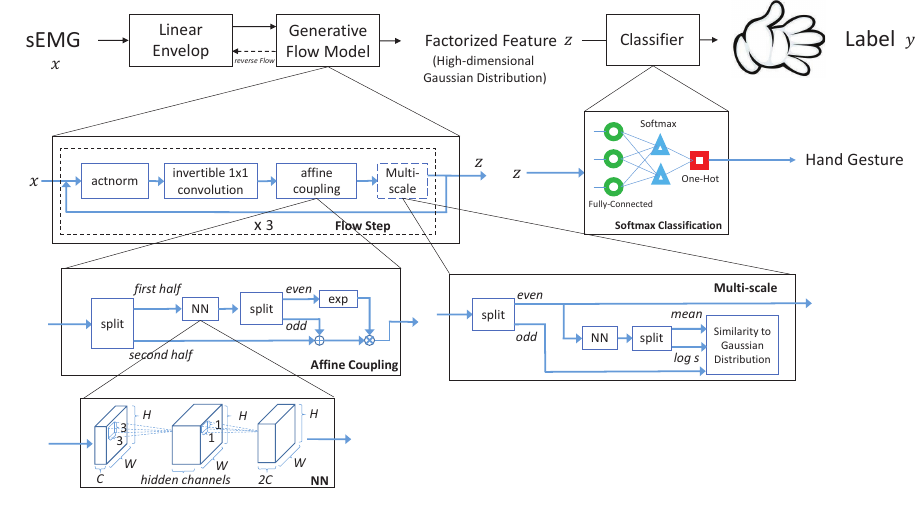
Figure 3. Overall structure of the proposed approach.